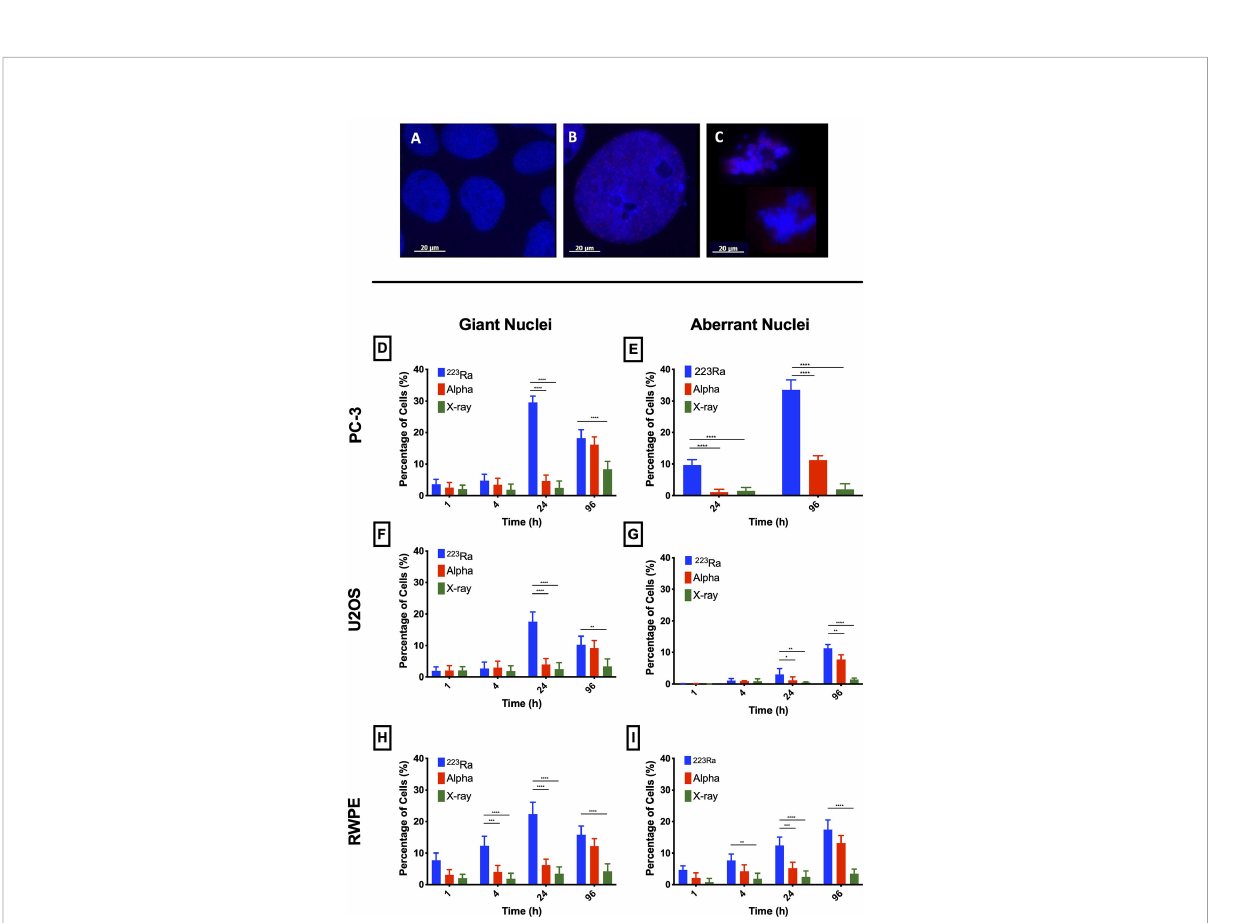
FIGURE 6 Typical nuclear morphologies observed after 1 Gy of 223 Ra irradiation in 24 h and fi xed at 96 h after exposure; cell nuclei were labeled with DAPI. (A) U2OS control cells. (B) Morphology of a giant nuclei cell after irradiation. (C) Aberrant nucleus representative of cells that undergo mitotic catastrophe after irradiation. (D – I) Mitotic catastrophe in response to 223 Ra irradiation is cell-speci fi c. In all cell lines [PC-3 (D, E) , U2OS (F, G) , and RWPE (H, I) ], there is a peak of giant nuclei at 24 h after 223 Ra exposure and a peak for aberrant nuclei at 96 h after 2 Gy of irradiation. Bars represent the mean of three independent experiments and the respective standard error. Analysis was performed using t-student method; A signi fi cant change when compared to the control group is represented by * ( p < 0.05; ** ( p < 0.01); *** ( p < 0.001); **** ( p < 0.0001).